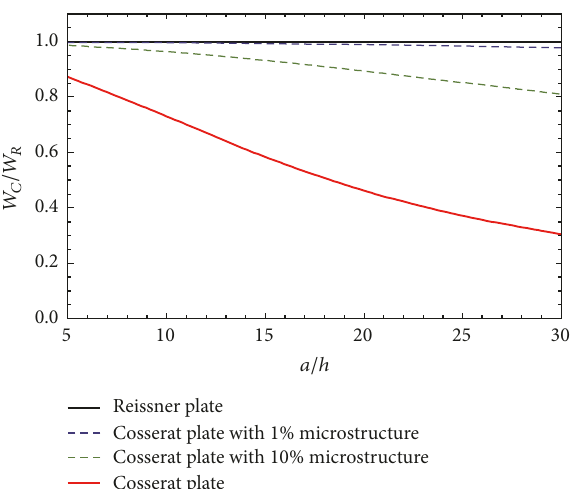
Figure 10: Comparison of the maximum vertical deflections of the circular plate with 4 holes, 𝑊 𝐶 (Cosserat) with 𝑊 𝑅 (Reissner) for different values of width to thickness ratio 𝑎/ℎ , which illustrates the influence of the thickness of the Cosserat